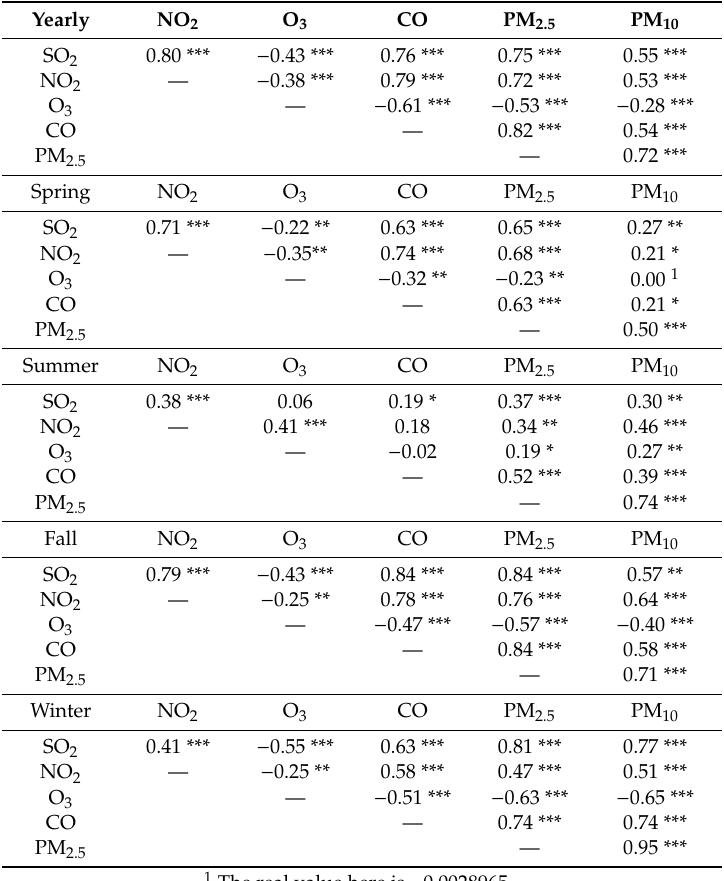
Table 4. Annual and seasonal correlations of six criteria air pollutants in Spearman correlation coe ffi cient. Daily measurements were used for calculation. Strong correlation: | ρ | > 0.5;